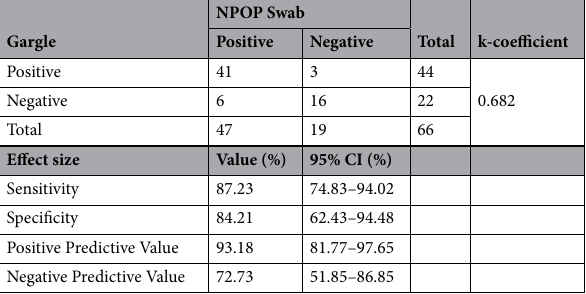
Table 1. Detection of SARS-CoV-2 from extracted RNA from NPOP swabs versus gargle specimens of inpatients in RSDK and RSND.